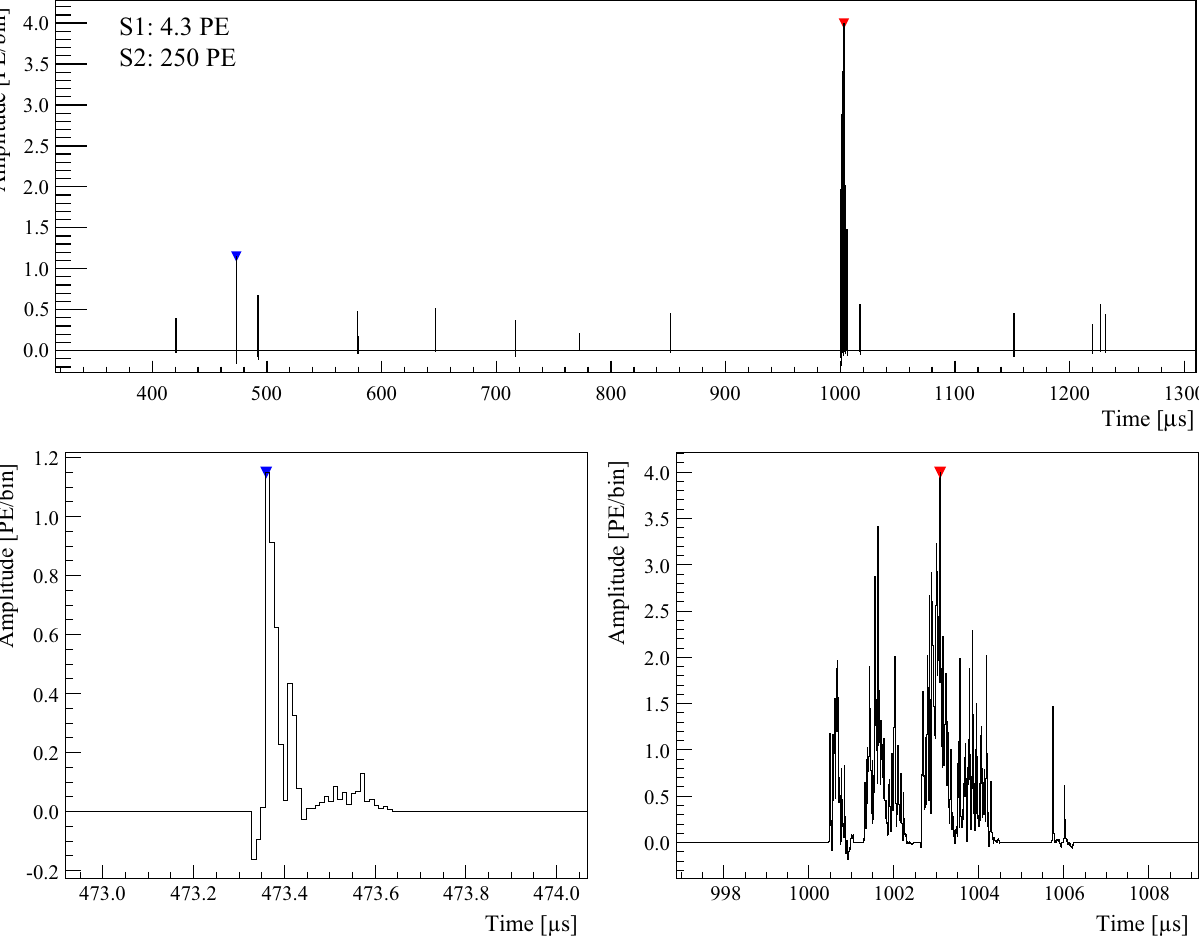
Fig. 16 Low-energy single-scatter NR event recorded by XENON1T during a 241 AmBe calibration run. All panels show the sum of all TPC PMT waveforms. An S1 signal of 4.3PE (blue marker) is followed by an S2 signal of 250PE (red), where the quoted numbers do not yet take into account corrections. The drift time of 529.7 µ s corresponds to a